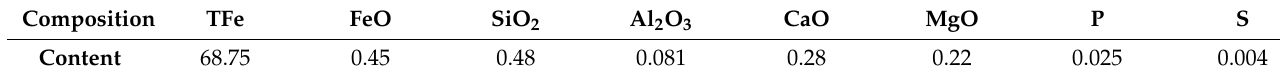
Figure 1. X-ray diffraction pattern of hematite. Table 1. Chemical composition of hematite sample (mass, %).